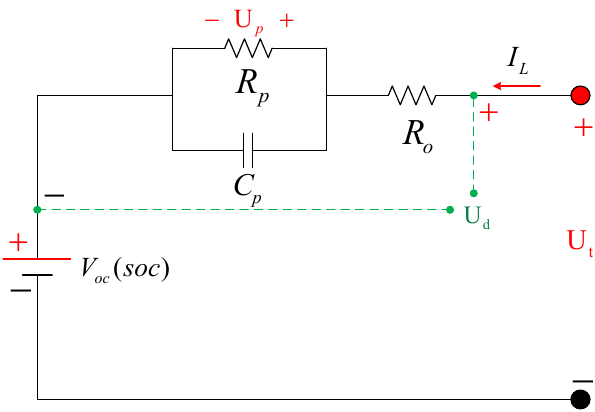
Figure 1. The schematic diagram of the equivalent circuit model for lithium-ion